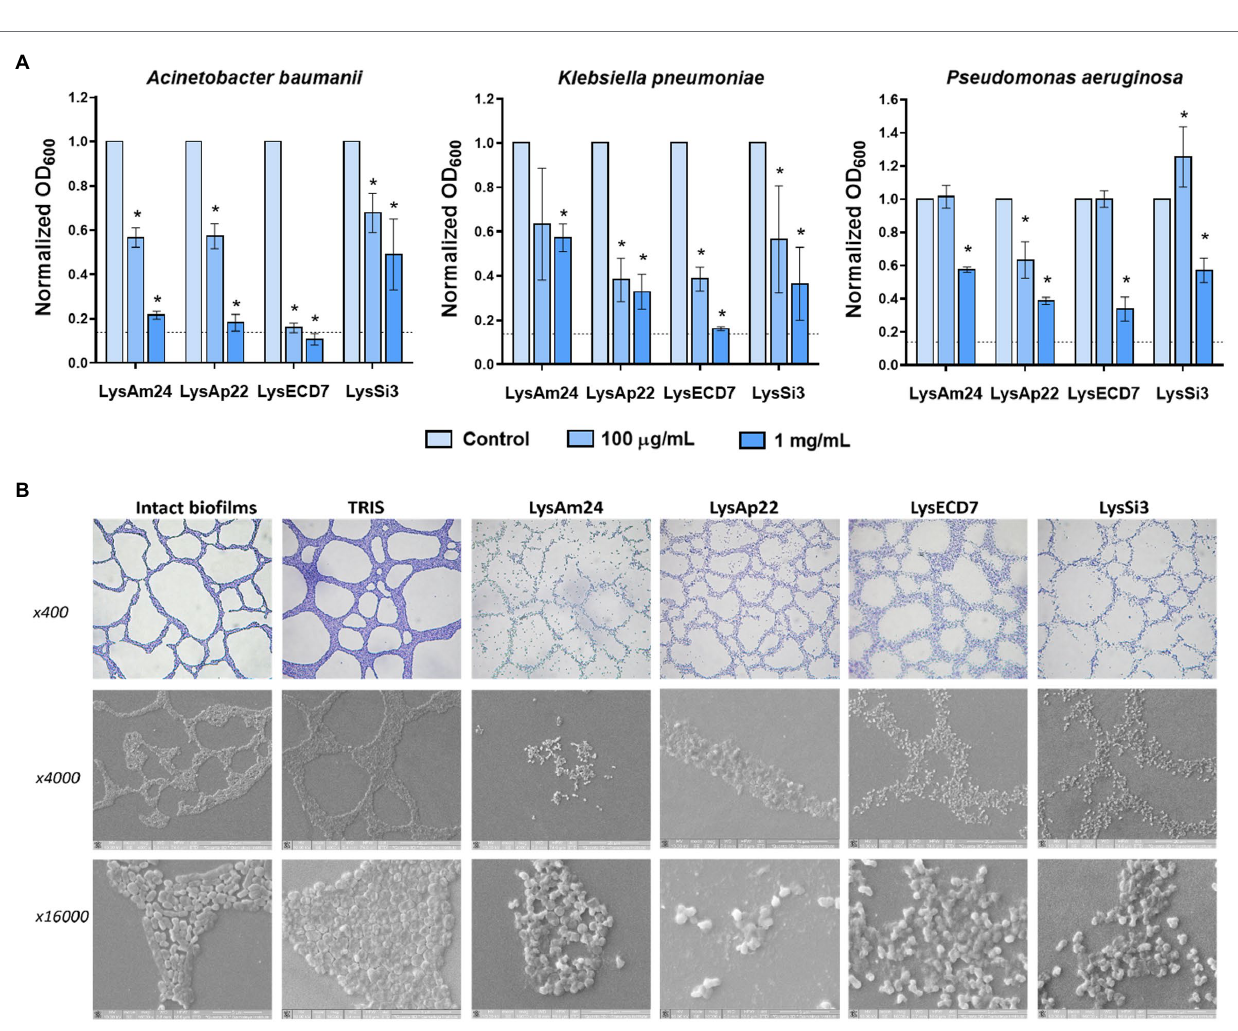
FIGURE 2 | Disruption of bacterial biofilms by endolysins. (A) Antibiofilm activity of endolysins against Klebsiella pneumoniae Ts 104-14, A. baumannii Ts 50-16, and Pseudomonas aeruginosa Ts 38-16 biofilms stained with crystal violet. OD 600 was measured after 2 h of exposure to endolysins. Dash line indicates the cutoff value calculated as three SDs above the mean OD of the negative control. Data are shown as mean ± SD. Asterisk (*) indicates significant difference in optical density compared to control without the enzyme treatment of biofilm ( p < 0.05, one-way ANOVA). (B) Light and scanning electron microscopy images of lysis